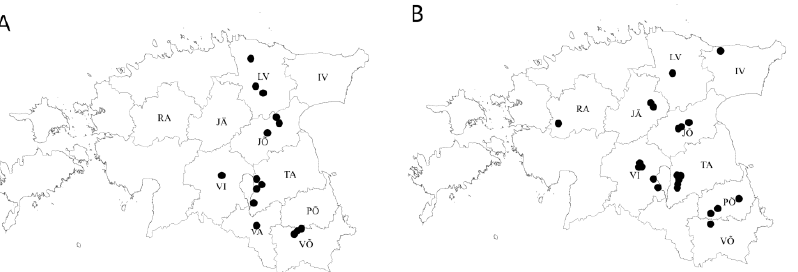
Figure 1. Spring barley fields of R. collo-cygni collection in 2019 ( A ) and 2020 ( B ) in Estonia. Table 1. The number of R. collo-cygni collection fields and isolates analysed for mutations in fungi- cide target genes and fungicide sensitivity in microtiter plate assays by counties and years.